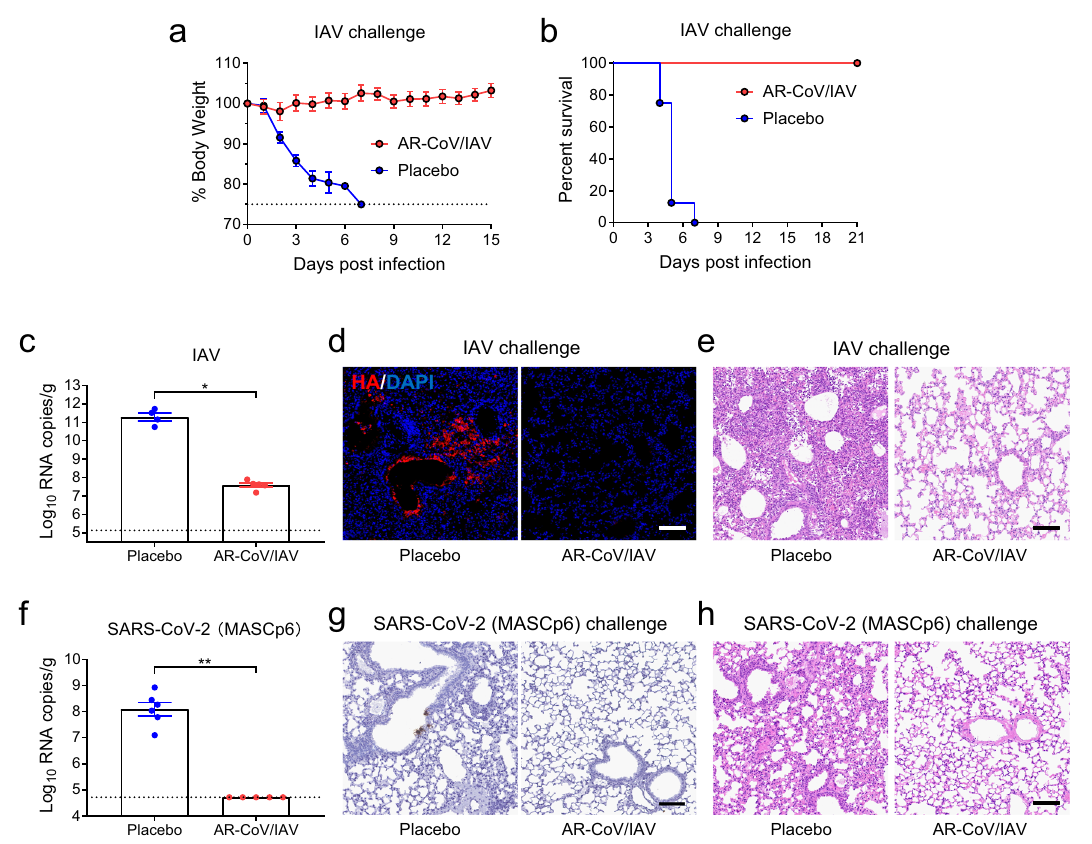
Fig. 4 AR-CoV/IAV protects mice from an IAV or SARS-CoV-2 challenge. AR-CoV/IAV- or placebo-immunized mice were challenged with 1.5 × 10 6 PFU of IAV (A/California/07/2009) ( a – e ) or 1.6 × 10 4 PFU of SARS-CoV-2 (MASCp6) ( f – h ) at the indicated time points post-initial immunization. a Weight changes were recorded for 15 days and are shown as the mean ± SEM (AR-CoV/IAV, n = 7; placebo, n = 8). b Mortality was monitored for 21 days after inoculation. c Viral RNA copies in the lung tissues of IAV-infected mice (AR-CoV/IAV, n = 5; placebo, n = 4) were determined by qRT – PCR and are shown as the mean ± SEM. d Immunostaining results for HA protein in lung tissues. e H&E staining of lung tissues from IAV-infected mice. f Viral RNA copies in the lung tissues of SARS-CoV-2-infected mice (AR-CoV/IAV, n = 5; placebo, n = 6) were determined by qRT – PCR and are shown as the mean ± SEM. g ISH assay of lung tissues from SARS-CoV-2-infected mice. h H&E staining of lung tissues from SARS-CoV-2-infected mice. Scale bar, 100 μ m. Statistical differences between groups were analyzed using two-tailed unpaired t tests. * P < 0.05, ** P <